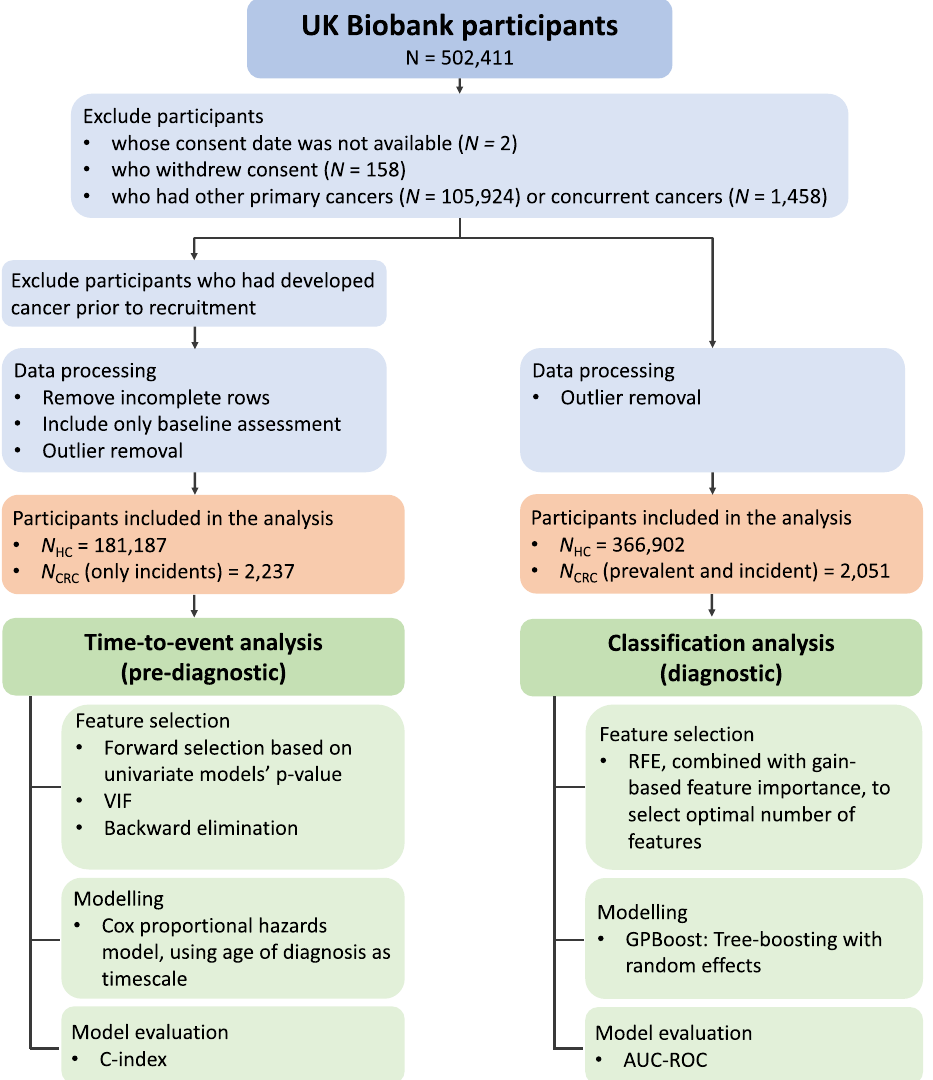
Figure 1. Analysis pipeline showing the distinct feature selection, modelling, and model evaluation steps of the time-to-event and classification analyses that aimed to identify pre-diagnostic and diagnostic biomarkers sensitive to